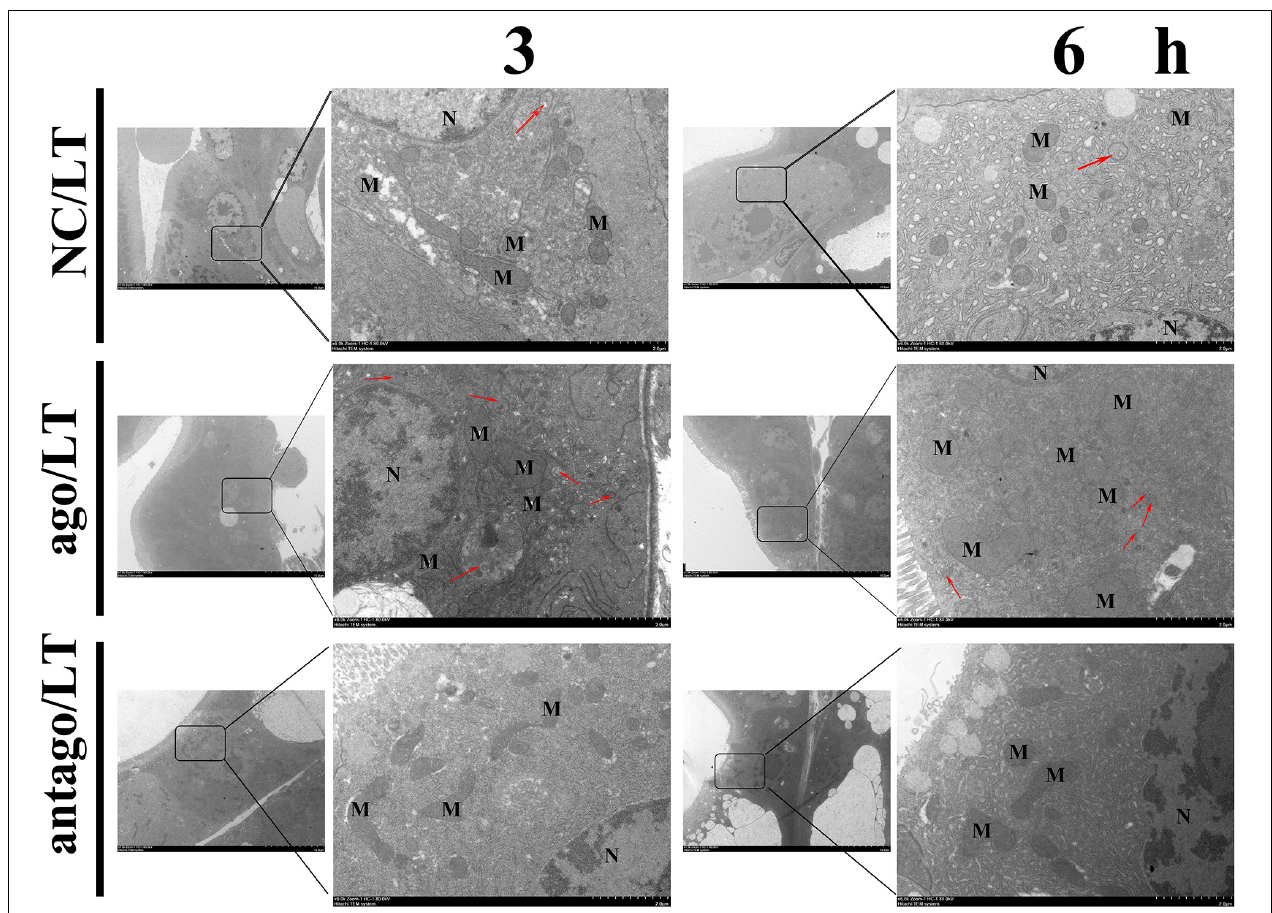
FIGURE 7 | TEM observation the hepatopancreas ultrastructure after pretreatment with ago-151 or antago-151. Mitochondria (M) are round or elongated, the matrix electron density is higher, the ridges are aligned, and there is obvious autophagy (red arrow) after pretreatment with ago-151. Nuclear (N) shrinkage and mitochondria (M) are sparsely distributed, with varying oval sizes, and the ridges are slightly expanded, disordered, and broken after pretreatment with antago-151.